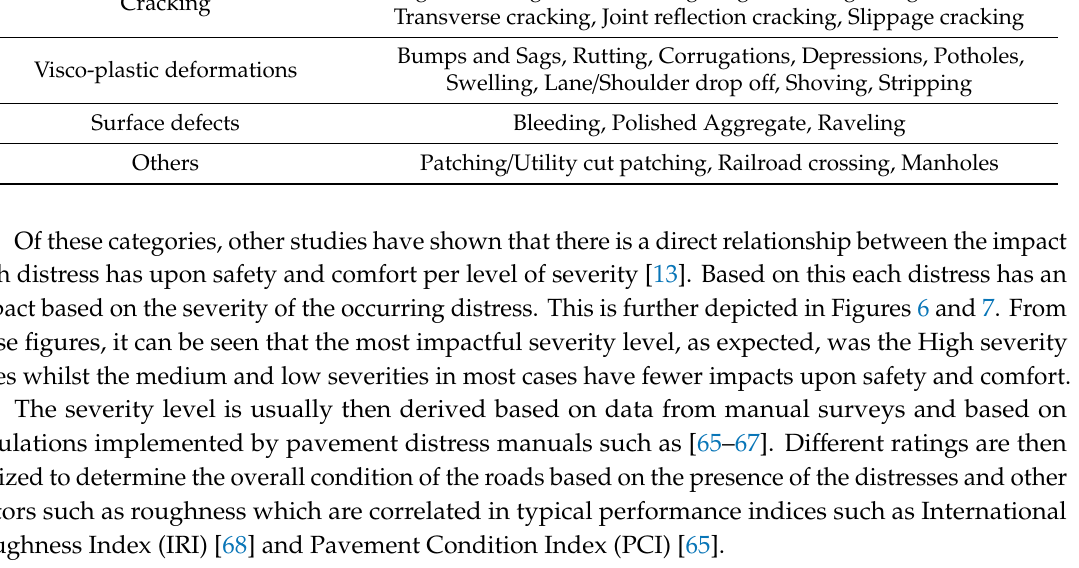
Table 1. Generalized pavement distress categories.